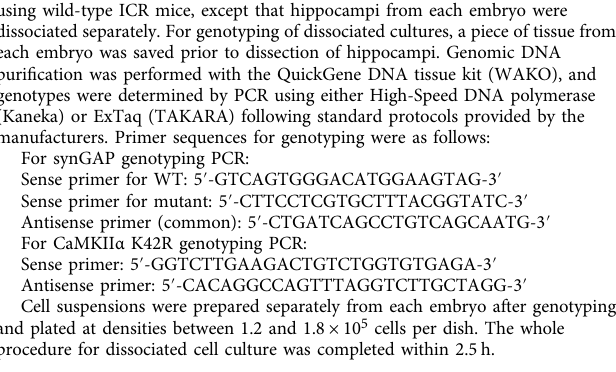
Fig. 4 Plasticity-related changes in spine head geometry. a Time course of changes in spine head volume after glutamate uncaging [one-way ANOVA; stimulated: n = 14 spines; neighbor: n = 14 spines; * p < 0.05, ** p < 0.01, *** p < 0.001]. b Structural changes in spine head before and after glutamate uncaging. SIM projection images of spines are shown in the upper row. Surface mapping of mean curvature and detected concave surfaces are shown in the middle and lower rows. Bar: 500 nm. c Images of reconstructed spine surface polygon with or without spine neck, convex hull mesh, and their overlay. Volume difference between the spine head and the convex hull was divided by the spine head volume, and this value is presented as the concave volume ratio for the graphs in panels ( d ) and ( f ). Bar: 500 nm. d Measurement of the volume difference between entire spine heads and the convex hull before and after glutamate uncaging. The graph shows the prolonged increase in this value after glutamate uncaging. [One-way ANOVA; stimulated: n = 6 spines; neighbor: n = 10 spines; * p < 0.05, *** p < 0.001]. e Inhibition of plasticity-associated changes in spine head geometry by neurexin 1 β -Fc. SIM projection images of spines are shown in the upper row for both control-Fc and neurexin 1 β -Fc conditions. The images in the lower rows show surface mapping of mean curvature. Bar: 500 nm. f Measurement of the volume difference between entire spine heads and the convex hull before and after glutamate uncaging in the presence of neurexin 1 β -Fc. [One-way ANOVA; control-Fc: n = 6 spines; Nrx1 β -Fc: n = 6 spines; * p < 0.05, ** p < 0.01, *** p < 0.001]. g Inhibition of PSD-95 accumulation in the late phase of spine structural plasticity by neurexin 1 β -Fc. Images of PSD-95-GFP are shown in the upper rows, and images of PSD-95-GFP merged with dsRed2 are shown in the lower rows. Bar: 500 nm. h Inhibition of PSD-95-GFP fl uorescence increase after glutamate uncaging by neurexin 1 β -Fc. [One-way ANOVA; control-Fc: n = 4 spines; Nrx1 β -Fc: n = 5 spines; * p < 0.05, ** p < 0.01]. Details of statistics in this